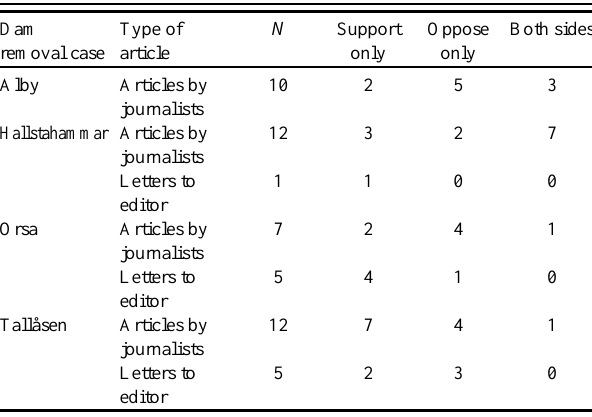
Table 2. Fragmentation of media coverage indicated by the inclusion of arguments in support of or opposition to the dam removal in online articles about four Swedish dam removal